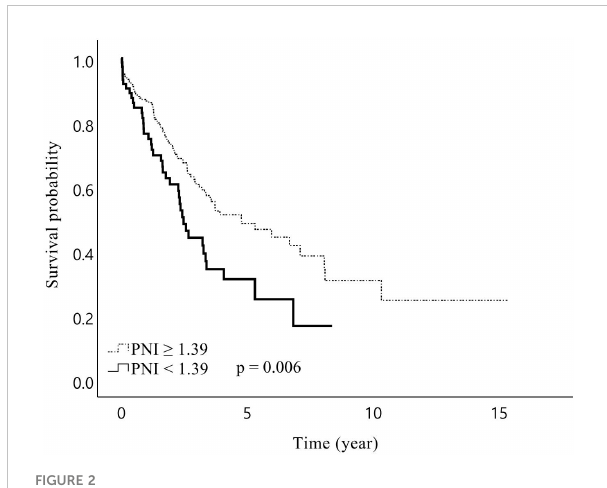
FIGURE 2 Kaplan – Meier curves for overall survival after hepatic resection of Klatskin tumors strati fi ed by prognostic nutritional index (PNI) Preoperative PNI lower than 1.39 was associated with a shorter overall survival for patients with Klatskin tumors following